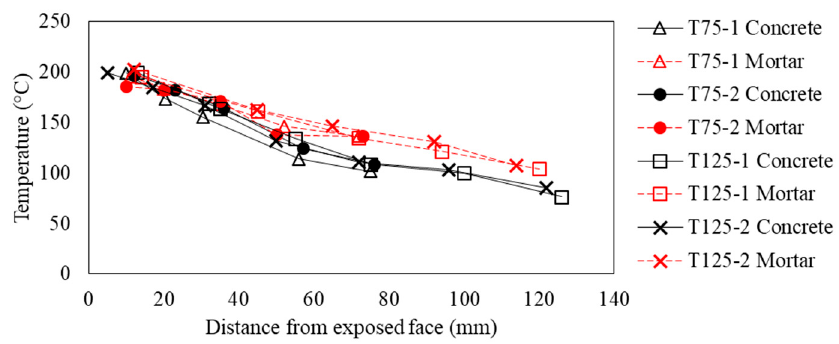
Figure 5. Thermal profiles in concrete and mortar at the end of the slow-rate heating.